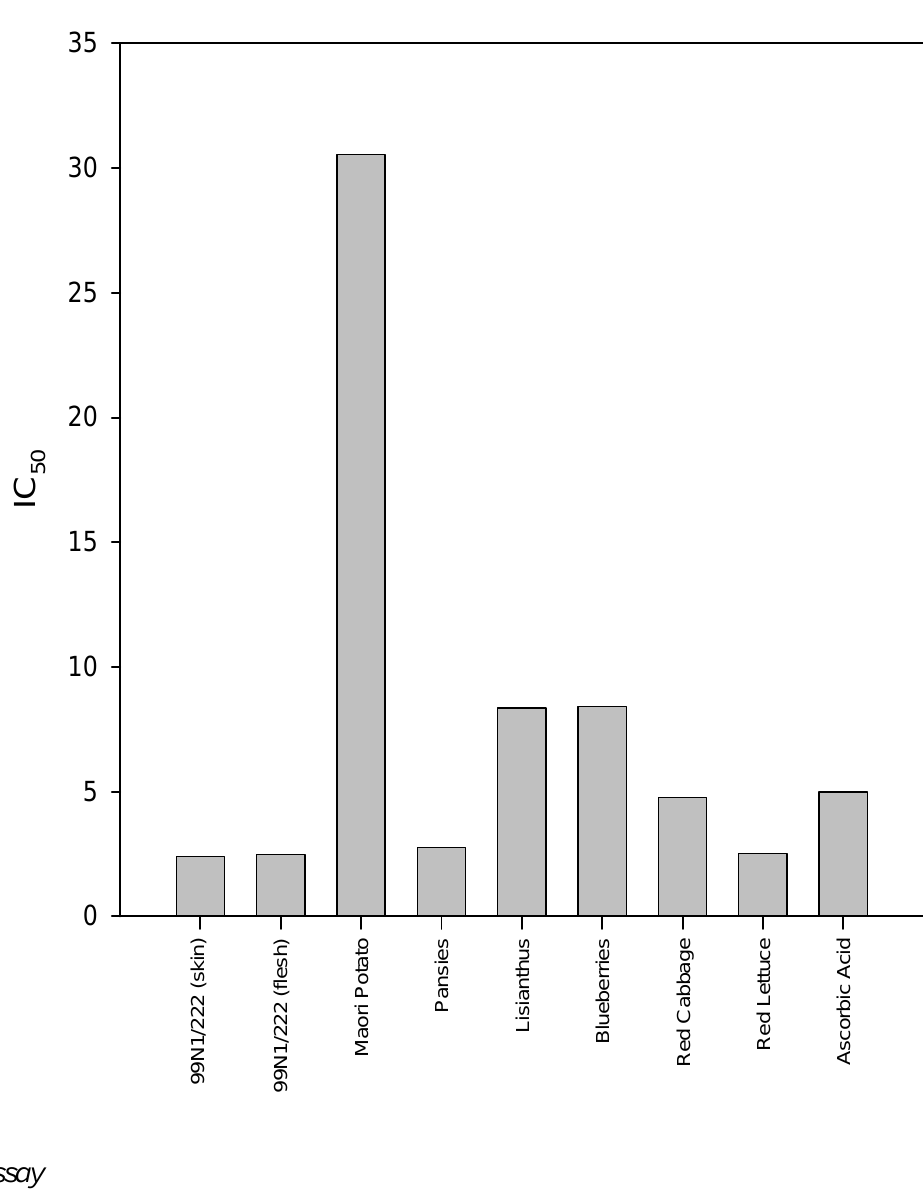
Figure 3 . Bar graph showing IC values for each extract from the DPPH assay. The IC 50 values represent the volume of extract required to reduce the absorbance of the DPPH radical by half and were calculated from the average of duplicate